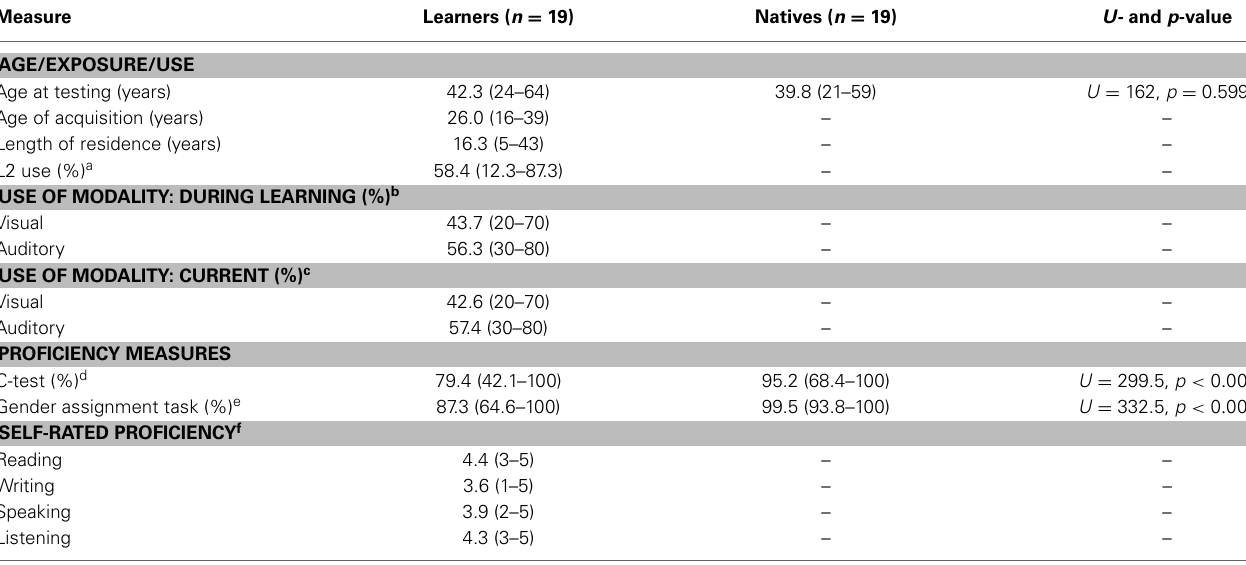
Table 1 | Means (and ranges) of participant characteristics and scores on proficiency measures, and significance of between-group comparisons (Mann-Whitney U